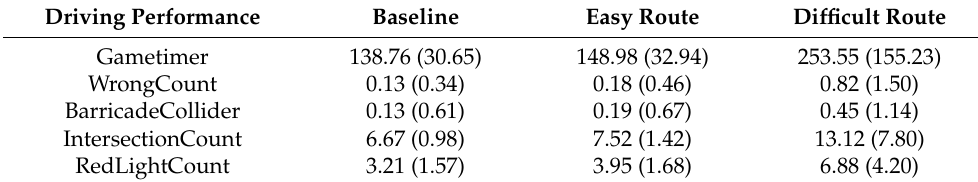
Table 3. Summary of Driving Performance